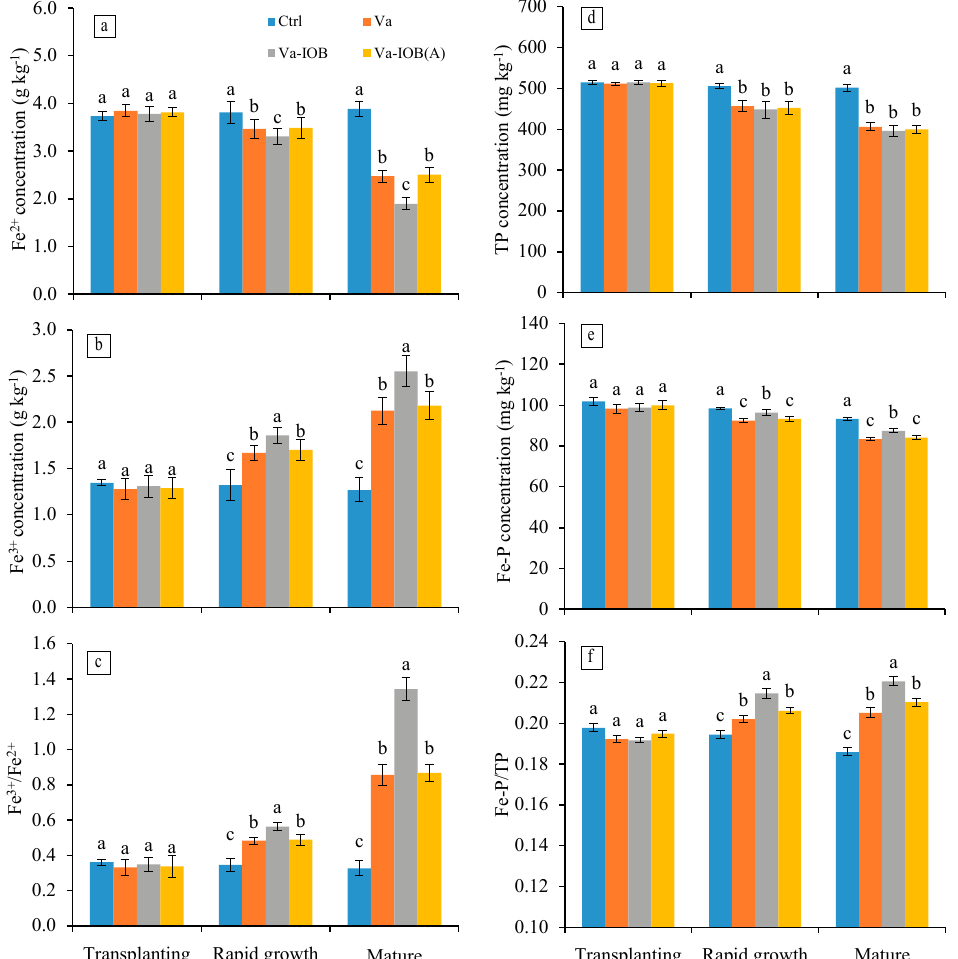
Figure 3. Iron and phosphorus concentrations in sediments under different treatments. ( a ) Dissolved Fe 2+ ; ( b ) dissolved Fe 3+ ; ( c ) ratios between Fe 3+ and Fe 2+ ; ( d ) total phosphorus (TP); ( e ) iron-bound phosphorus (Fe–P); and ( f ) proportions of Fe–P in TP (Fe–P/TP). Values are means ± standard deviation. For each stage, different lowercase letters above bars indicate significant differences at the 0.05 significance level by Tukey’s test.